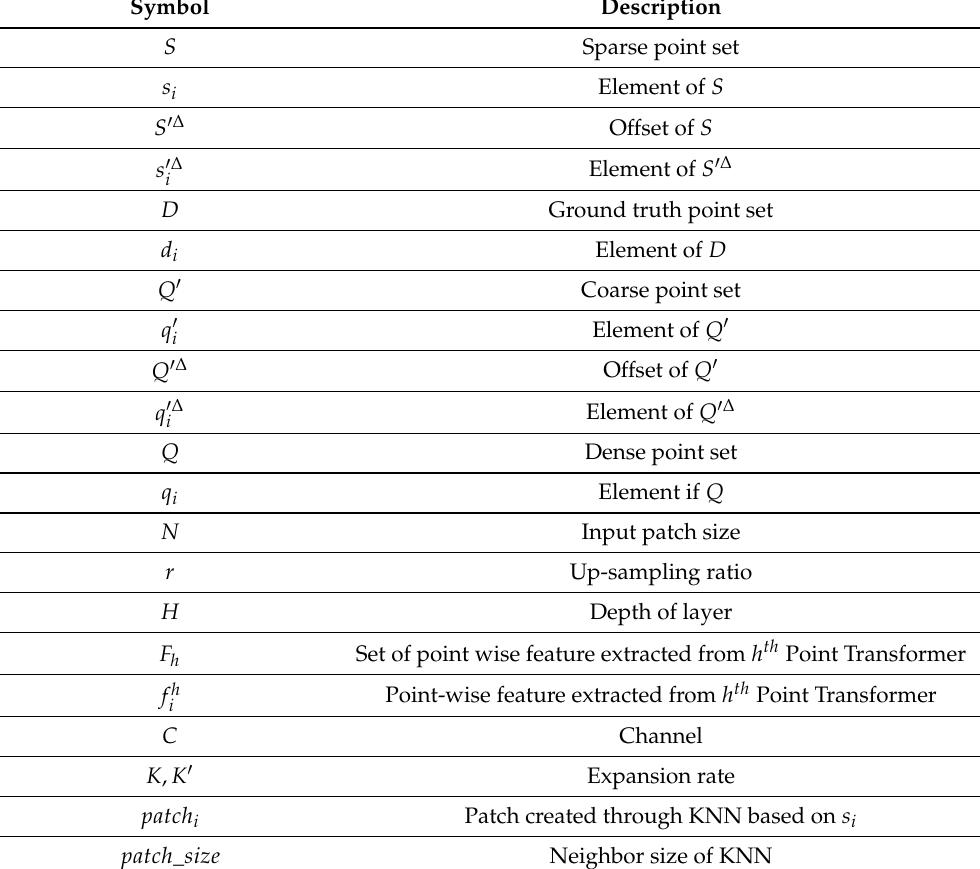
Table 1. Description of